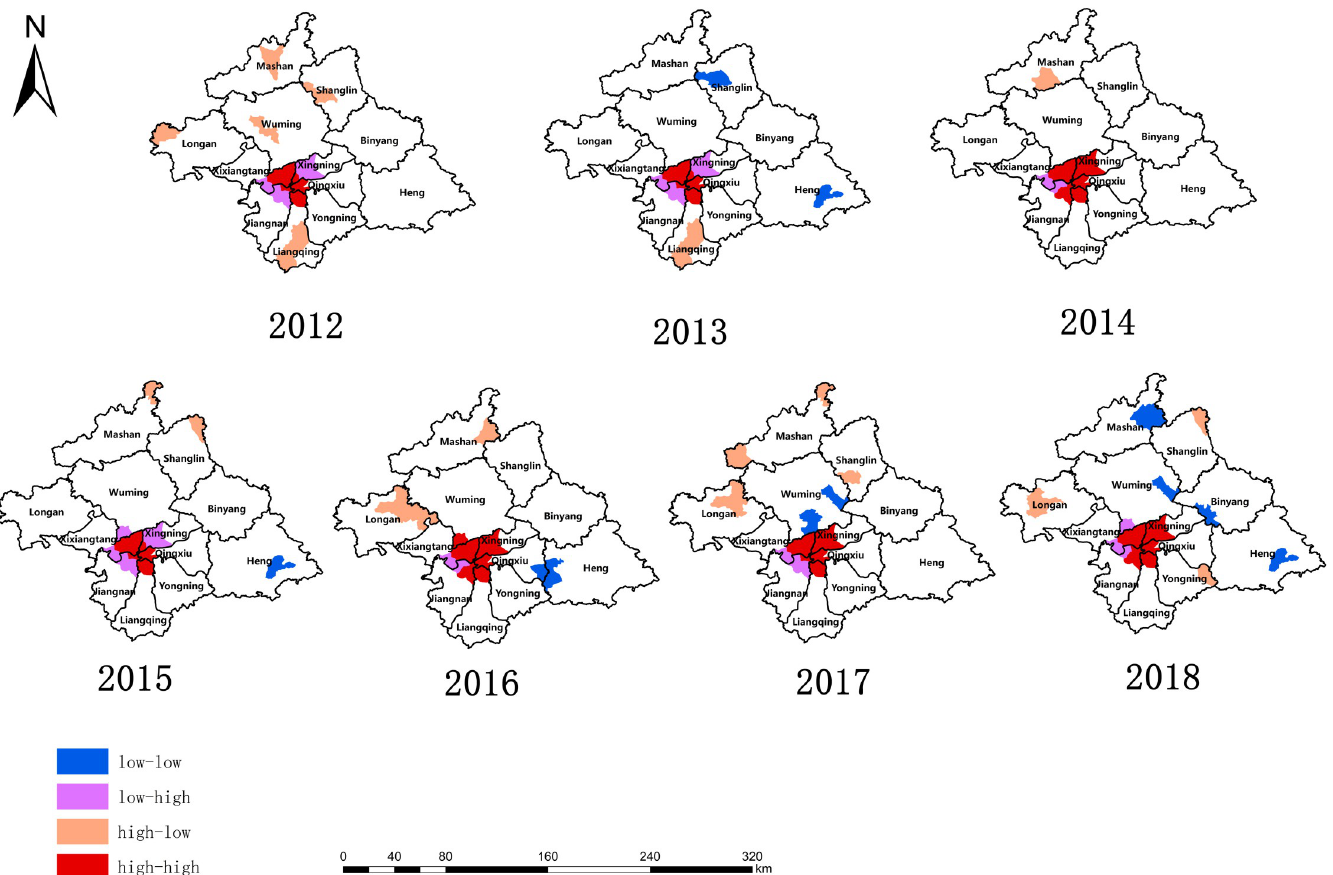
Fig 4. LISA spatial clustering pattern of reported incidence of pulmonary tuberculosis among students in Nanning from 2012 to 2018.